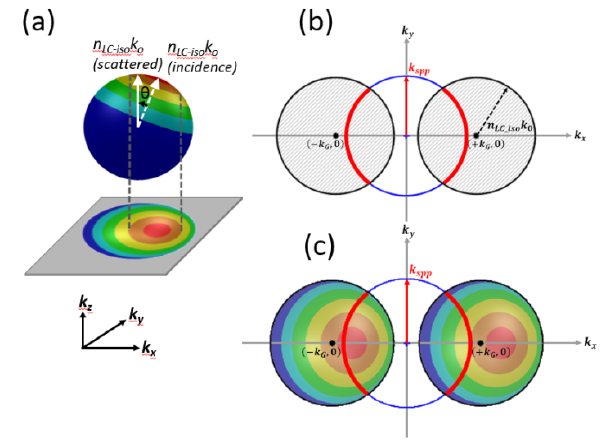
Figure 7. ( a ) k-sphere showing Mie scattering in photo-sensitive LC cell layer. The scattering angle can be derived from the colored projection map; ( b ) Mie scattering (full-circle) modulated by reciprocal grating vector (+1 and − 1 order). The red arcs represent the k vectors of Mie scattering fitted to k spp vectors; ( c ) Mie scattering (area map) showing regions of strong and weak coupling under Mie scattering. Table 1. Computed k spp values on Al film and Ni film from various data bases. The database values could be found in [45].